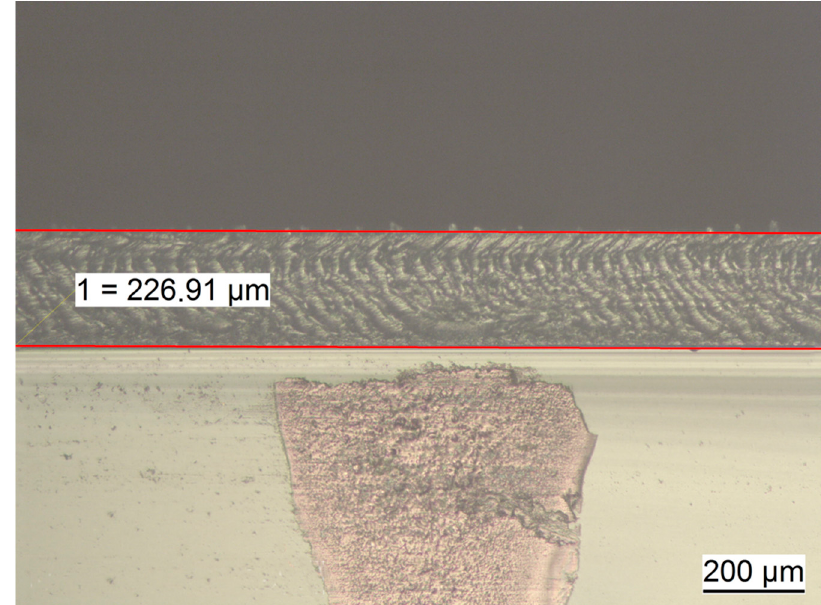
Figure 3. Thickness measurement procedure on a SF12 membrane. Thickness is determined by measuring the vertical distance between the two red parallel lines placed on the outer edges of the membrane cross-section. Top layer: blank space, middle: membrane, bottom layer: glass support.